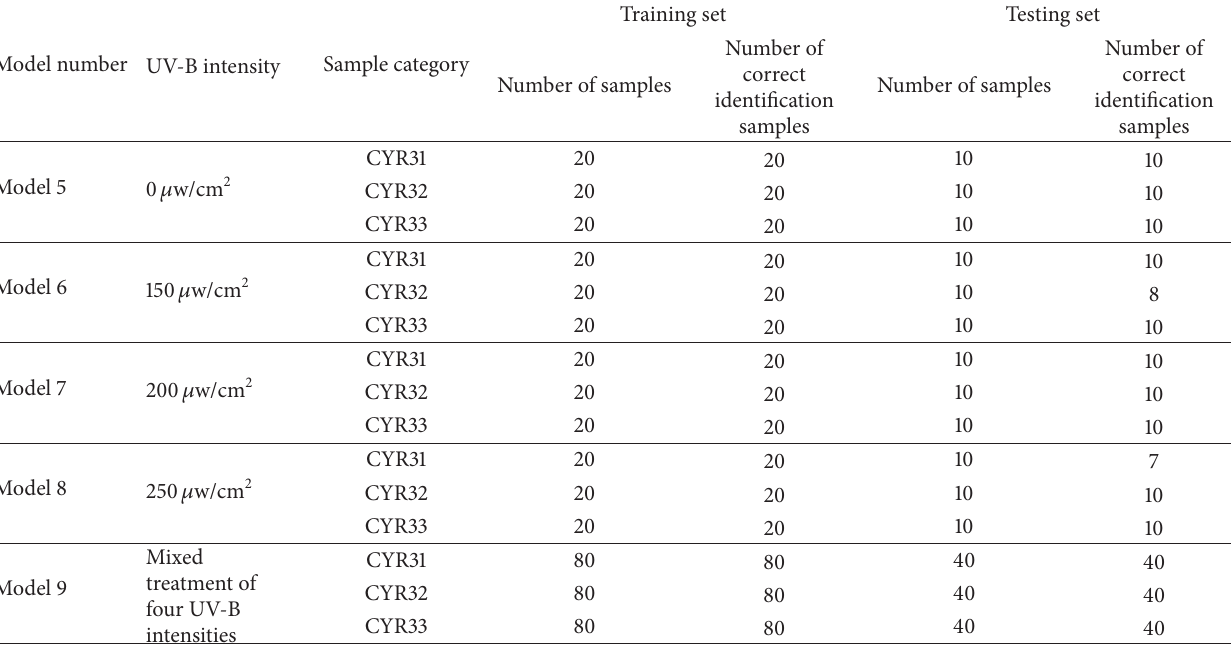
Table4:TheraceidentificationresultsusingSVMmodelsfor0 𝜇 w/cm 2 treatment,150 𝜇 w/cm 2 treatment,200 𝜇 w/cm 2 treatment,250 𝜇 w/cm 2 treatment, and total intensity treatments,